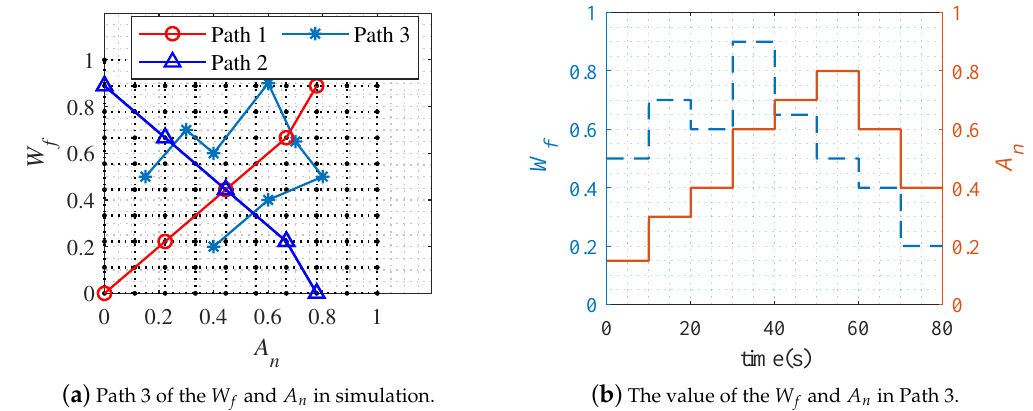
Figure 15. The input variables W f and A n for the identification of the EME model at dynamic off-design